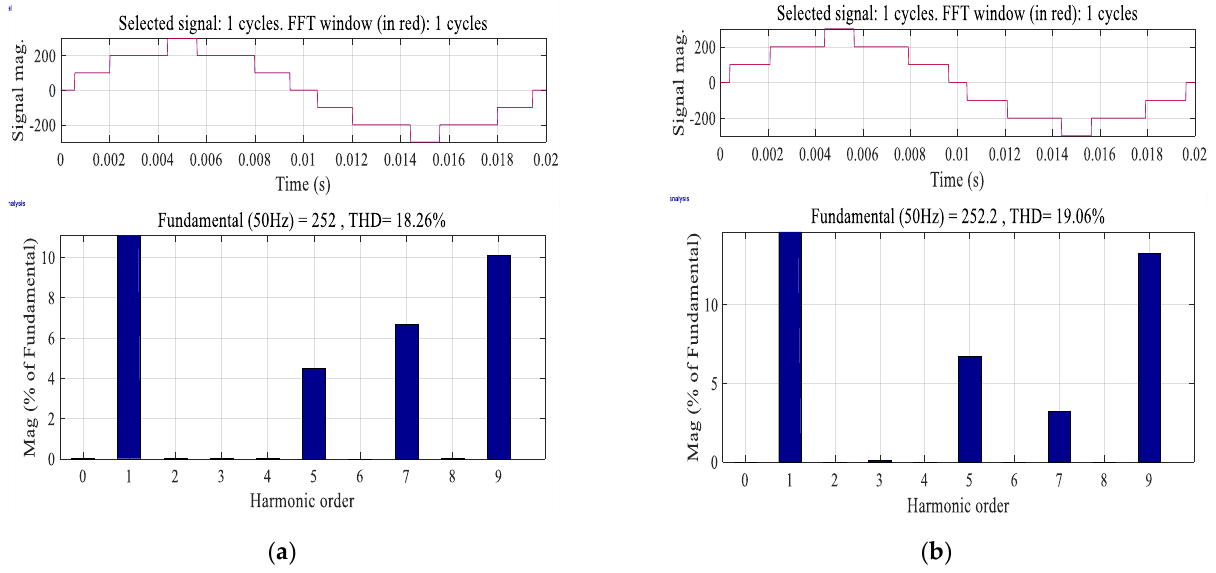
Figure 6. FFT analysis for 3rd order harmonic elimination at m = 2.52 using ( a ) the proposed technique and ( b ) the conventional technique.